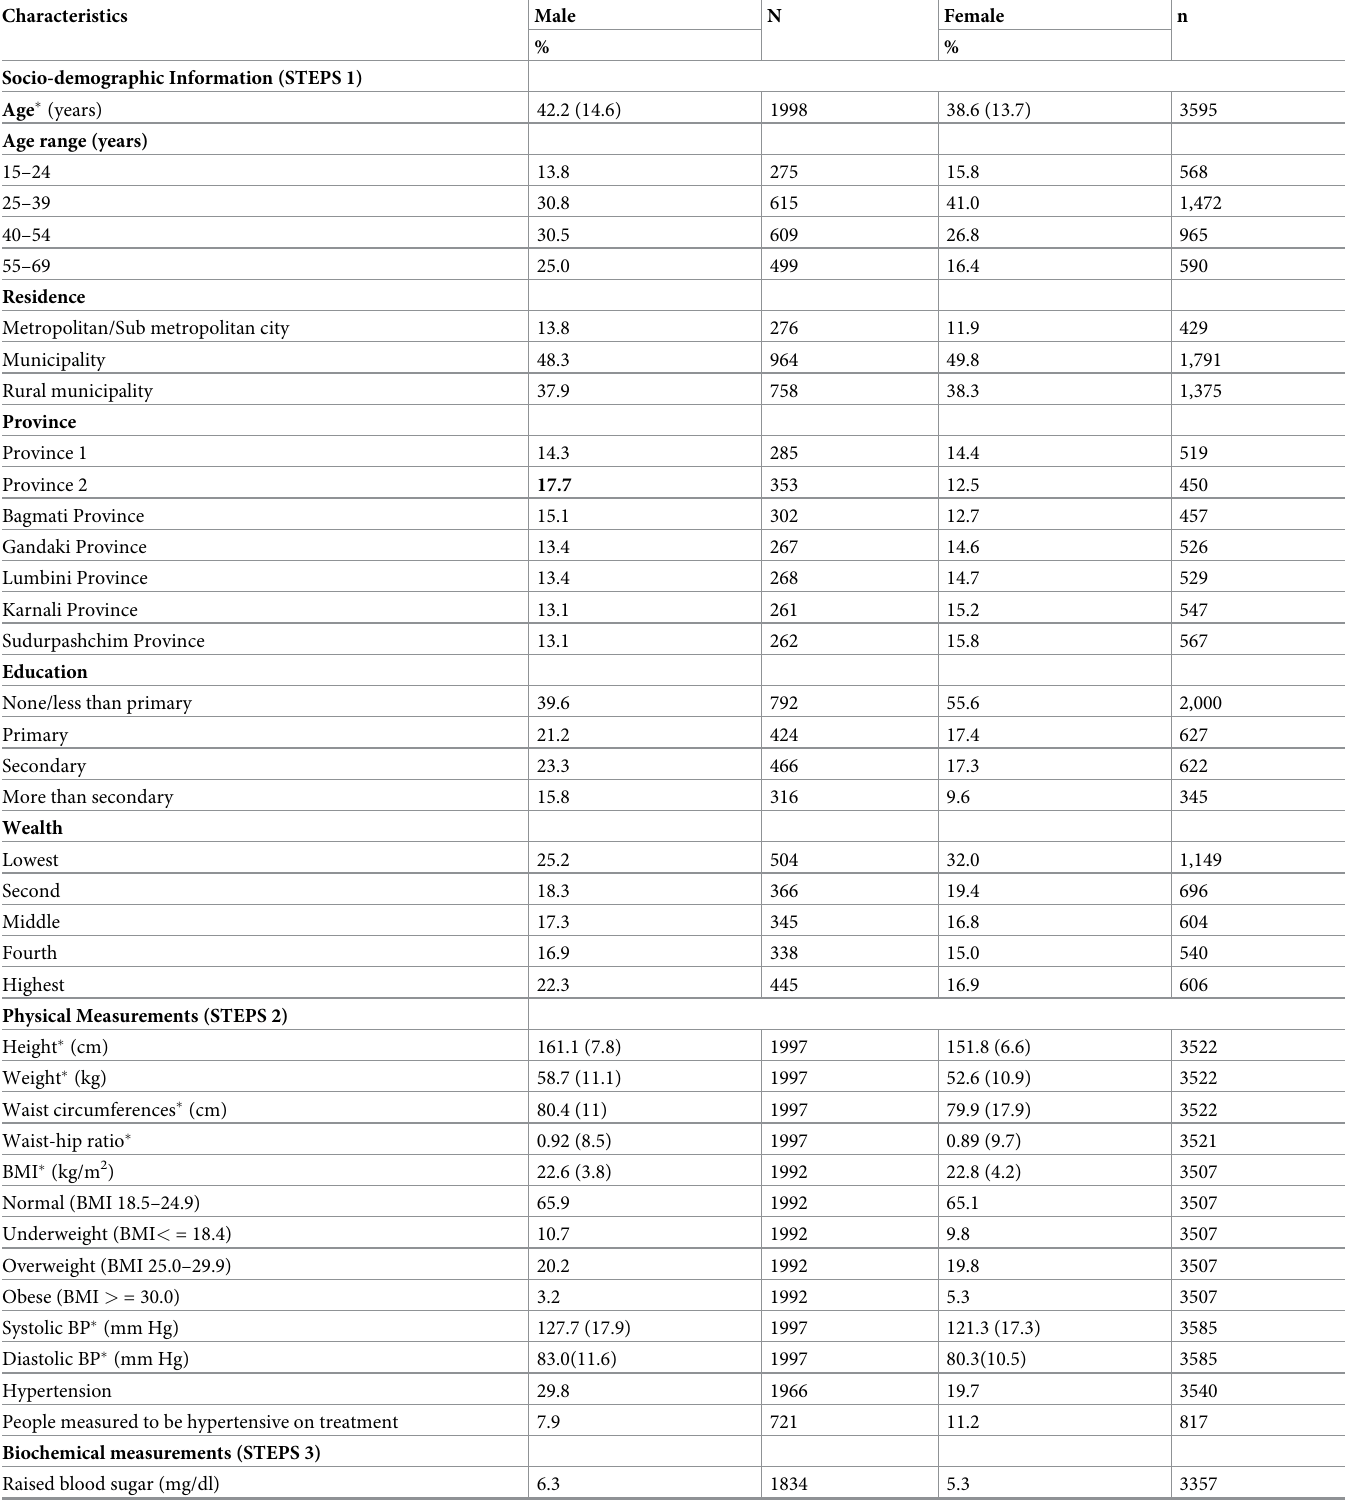
Table 1. Study population